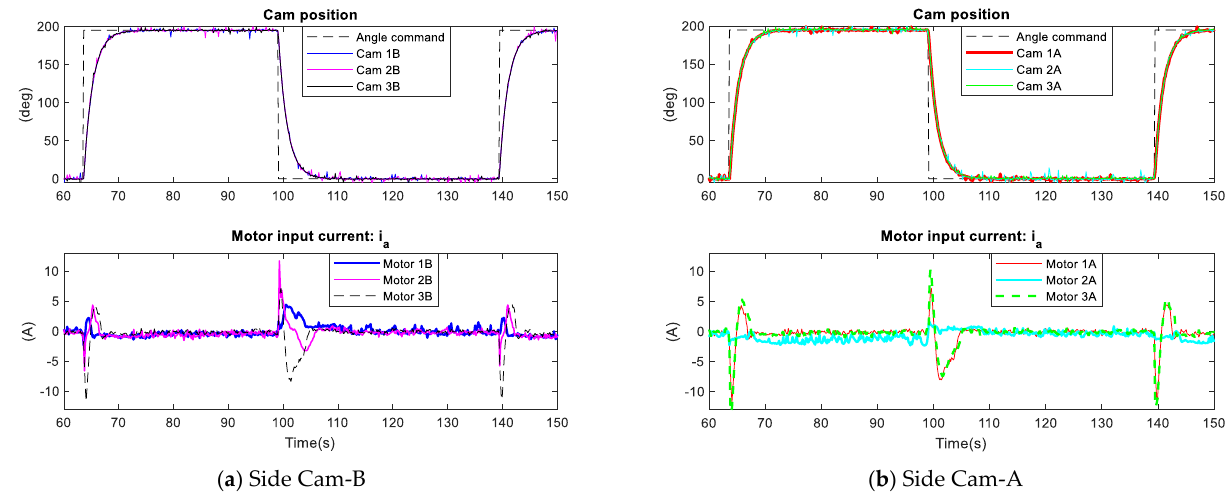
Figure 13. Experimental result, at railway environment, showing the angular position and the current of three mechatronic bearers of the novel track switch. The system operating with all three bearers; B1, B2 and B3.